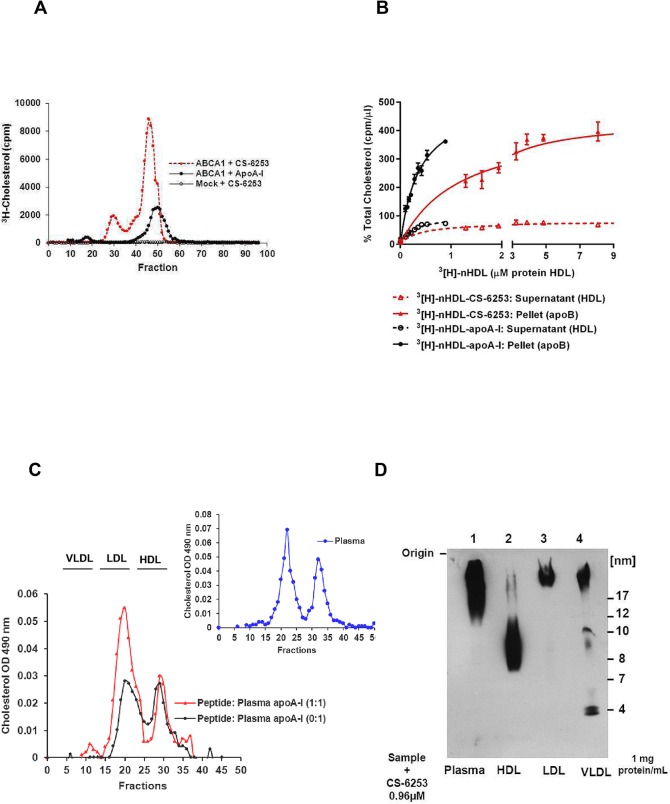
Dynamics of transfer and redistribution of BHK-ABCA1 cell-derived cholesterol content of nHDL-CS-6253.nHDL-CS-6253 particles were labelled with cell derived 3[H]cholesterol and incubated with normolipidemic plasma for various time periods at 37°C (1μg peptide: 10μg plasma apo A-I). A. Characterization of lipid particles released to the medium in the presence of CS-6253. 3[H]-cholesterol-labelled BHK cells expressing ABCA1 or not were incubated in the presence of 0.96 μM apo A-I (solid line) or CS-6253 (dashed line) for 45min at 37°C. Concentrated medium from cells was analysed by FPLC, and radioactivity associated with each fraction was determined. B. Transfer of total 3[H]cholesterol from 3[H]nHDL-CS-6253 to plasma lipoproteins. nHDL-CS-6253 or nHDL-apo A-I were generated after incubation (4h) of BHK cells expressing ABCA1 with increased doses of lipid free CS-6253 or apo A-I. Media cell culture containing 3[H]-nHDL-particles was incubated in human plasma for 1h, 37°C. After ApoB precipitation, fractions were dialysed and counted for radioactivity. Kinetic parameters for cholesterol transfer to apoB particles in plasma: nHDL-CS-6253 (439±0.20μM), Vmax (439± 19.74%cpm/μl) vs nHDL-apo A-I (0.37 ± 0.035), Vmax (517±24.45).C. Effects of ex vivo incubation of CS-6253 on plasma cholesterol lipoproteins. FPLC cholesterol profiles (OD 490 nm) of plasma apo A-I: peptide ratio (1:1) (dashed line) and plasma apo A-I: peptide ratios (1:0; i.e. apo A-I alone) (solid line) are obtained after 5 min incubation at 37°C. In all experiment counts were made in triplicate, (*P<0.05 by Student‘s t-test). For reference purposes, the inset shows an FPLC profile of normal plasma. D. Effect of ex vivo incubation of CS-6253 on plasma lipoproteins after separation by ND-PAGGE (5–35%) electrophoresis. CS-6253 (0.96 μM final dose) was incubated for 1h at 37°C with HDL, LDL or VLDL isolated by ultracentrifugation or with human plasma and then separated by electrophoresis at concentration of 1 mg/protein/mL. Gel is followed by Western blot analysis with anti-CS-6253 antibody. Internal control was run on the left of the gel and detected by Ponceau S.